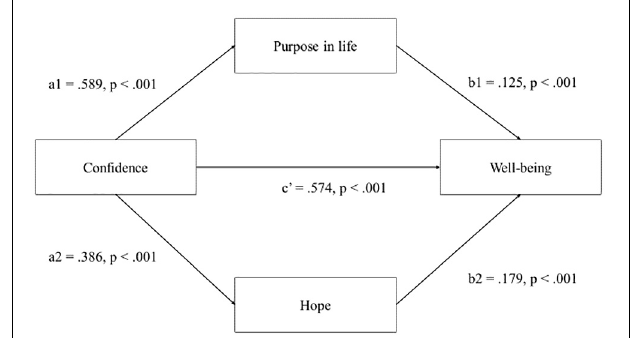
FIGURE 1 | Test of indirect associations for purpose in life and hope in relation to confidence and well-being.